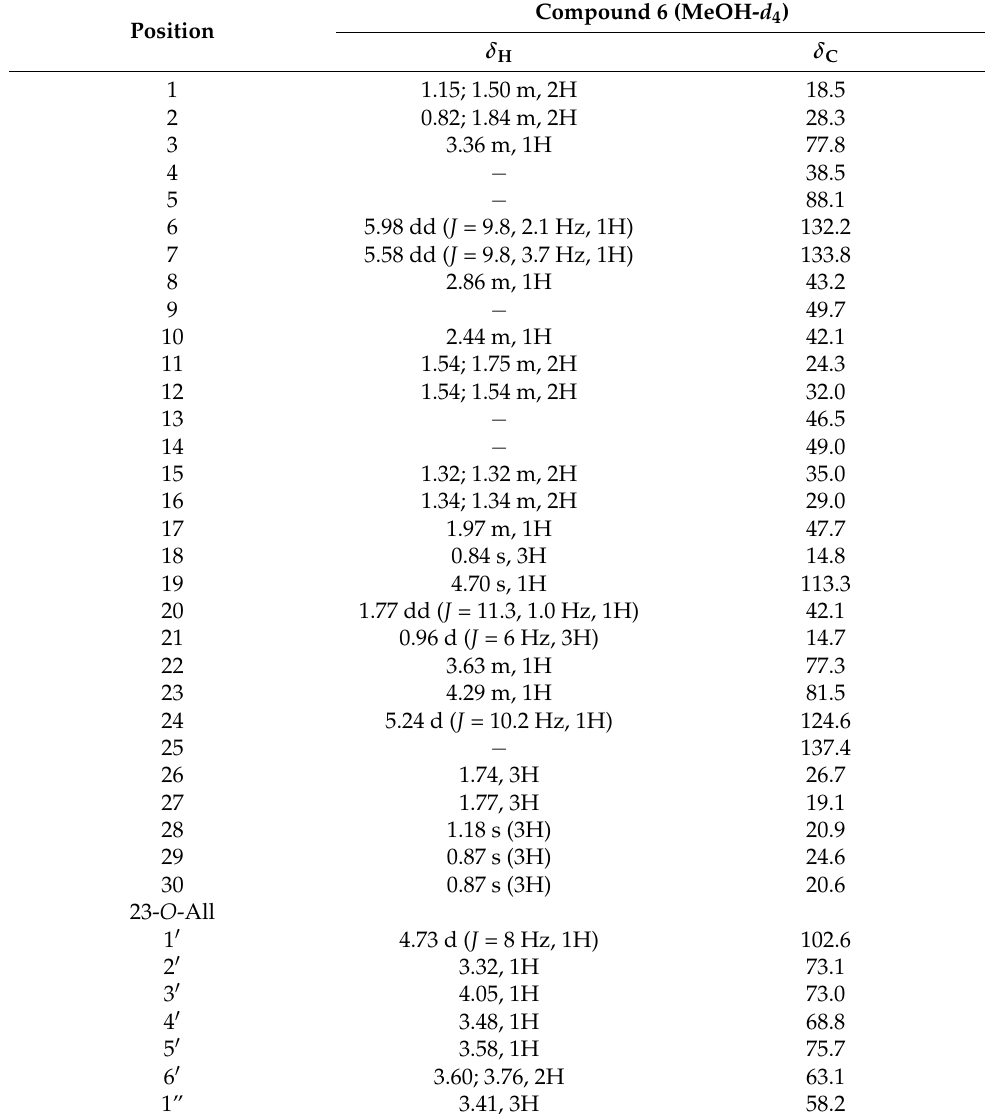
Table 1. 1 H and 13 C NMR chemical shifts of compound 6